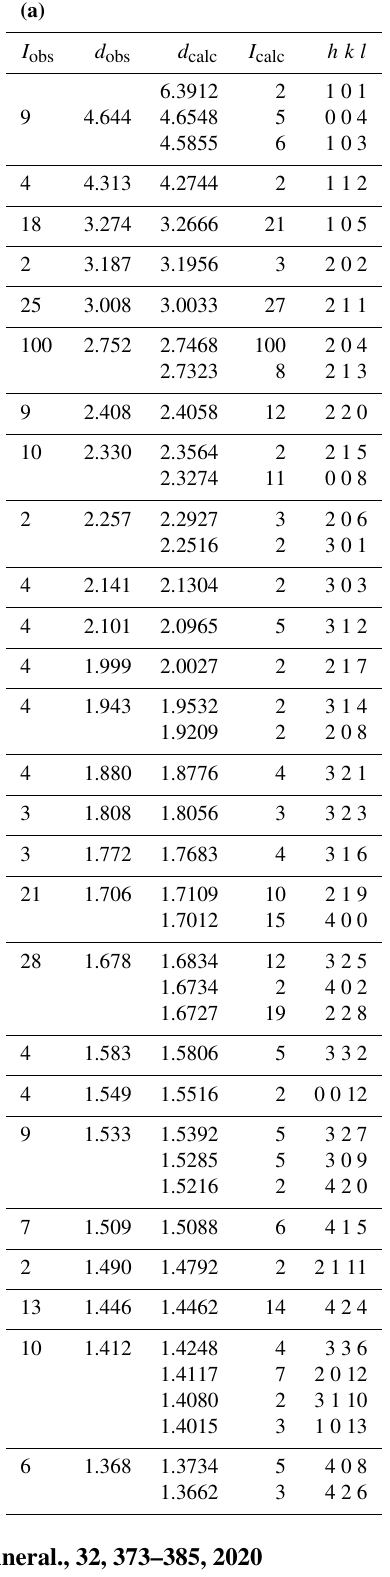
Table 2. (a) Powder X-ray data ( d in ångströms) for niasite. Only calculated lines with I ≥ 2 are listed. (b) Powder X-ray data ( d in ångströms) for johanngeorgenstadtite ∗ . Only calculated lines with I ≥ 2 after factoring are listed.